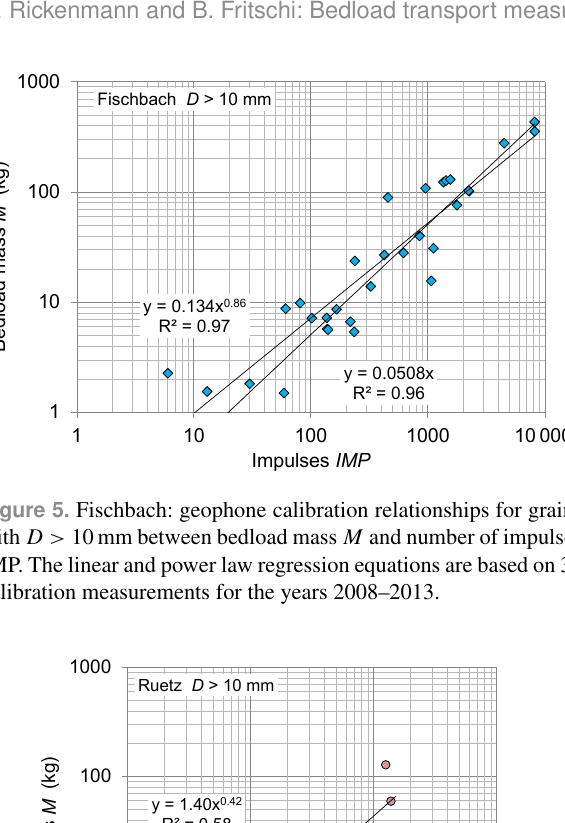
y = 1.40x 0.42 R² = 0.5 8